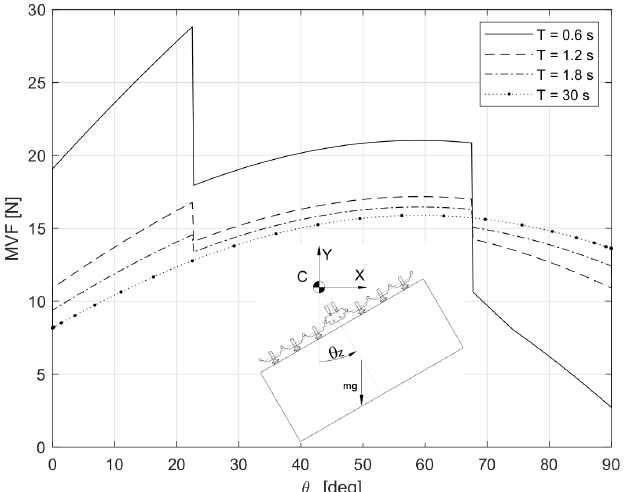
Figure 5. Minimum vacuum force required to rotate a box expressed as a function of the inclination angle θ z that is shown in the bottom inset. Different curves refer to increasing time T , i.e., the total time used for the rotation as defined in Equations (2)–(4).